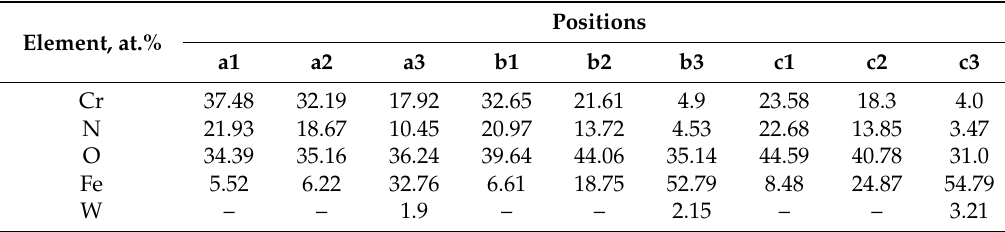
Table 5. The EDS analysis results corresponding to the positions in Figure 11.